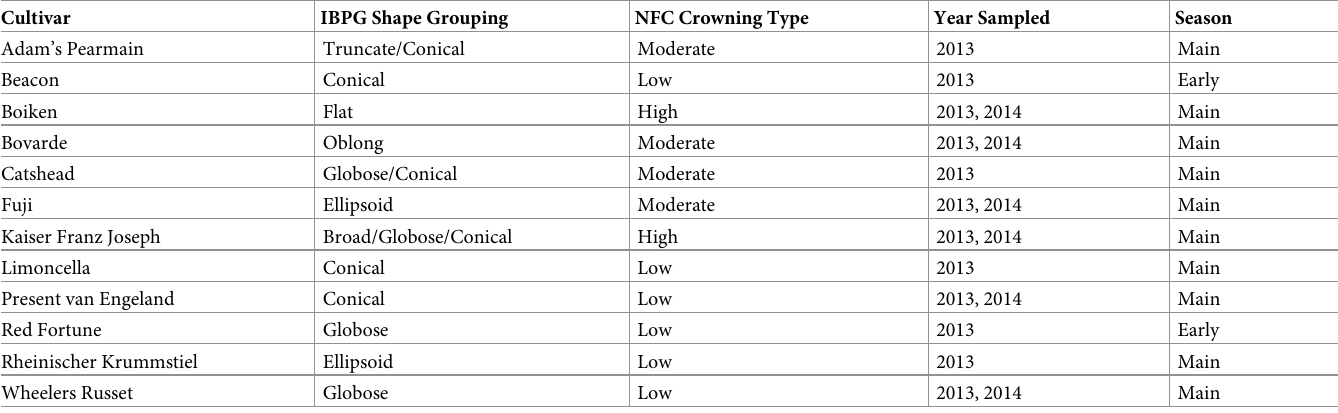
Table 2. Shape descriptions of selected cultivars.